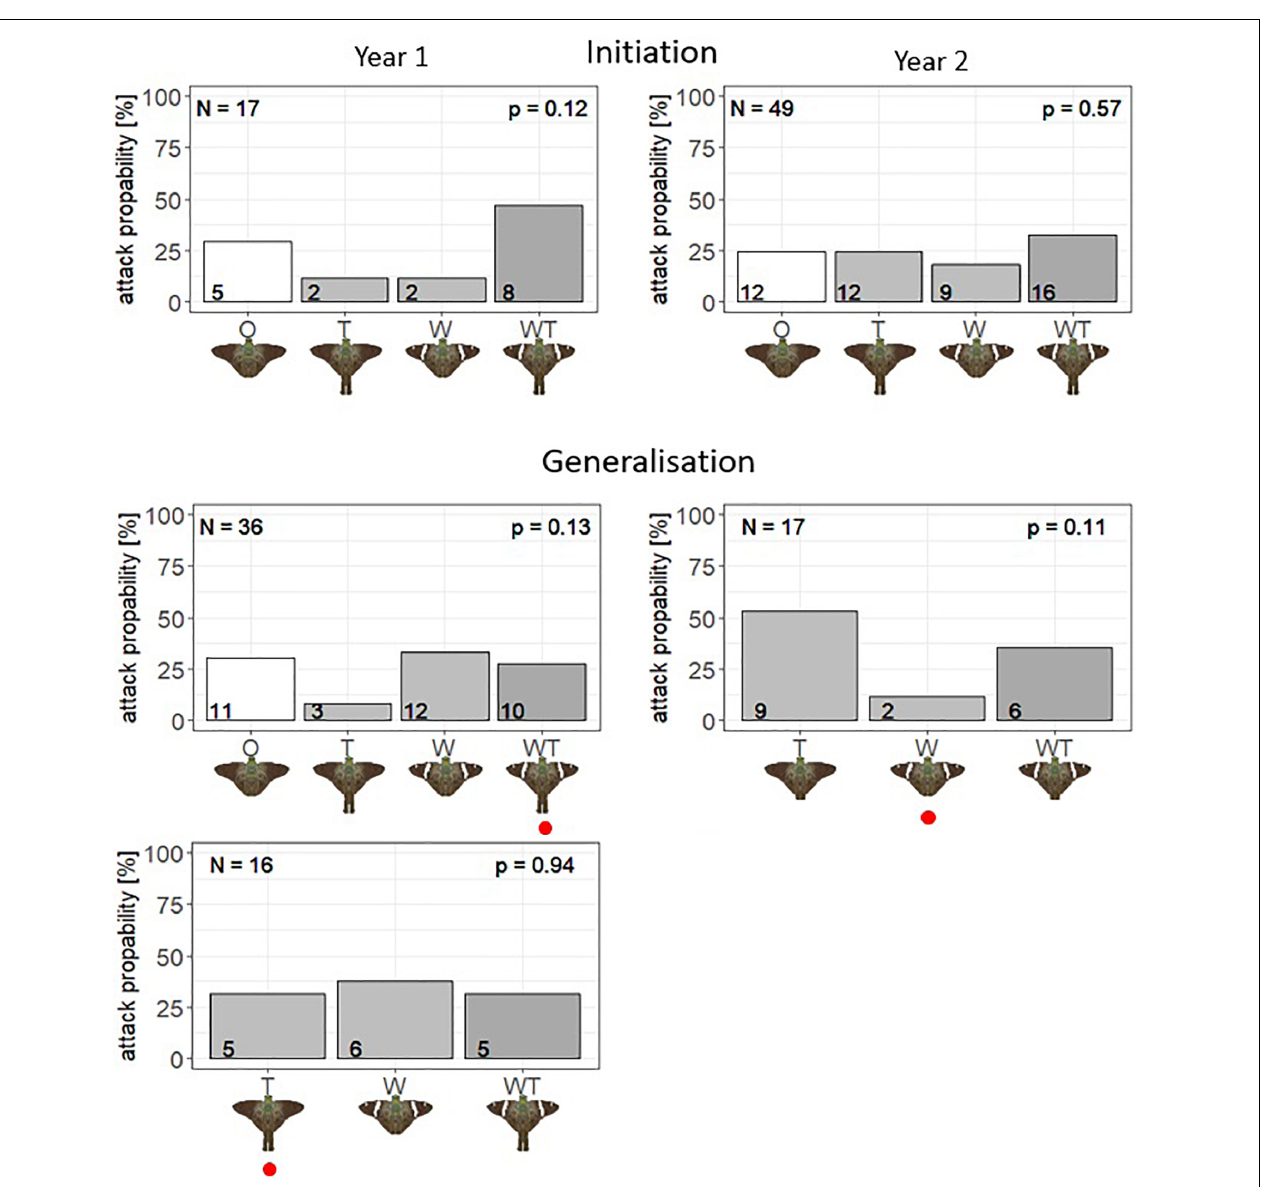
FIGURE 2 | Proportion of blue tits to first attack the different offered butterfly dummies (O, T, W, and WT) during Year 1 ( left column), and Year 2 ( right column). The first row represents Initiation results, while the second and third rows are representing Generalization results. The number in each bar indicates the absolute number of first attacks on this phenotype and the p -value is the result of the Chi-square test comparing any difference in attack rates among prey models within each experiment. The red circle marks the evasive model during the Learning